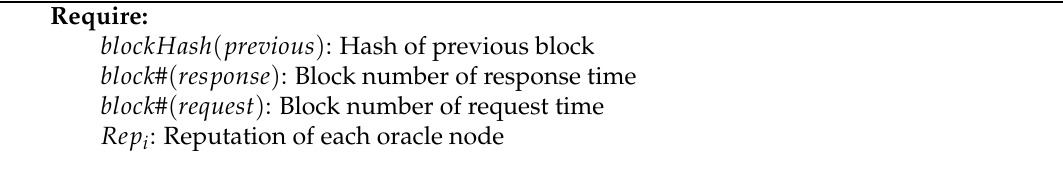
Algorithm 1: Reputation Management and Leader Election